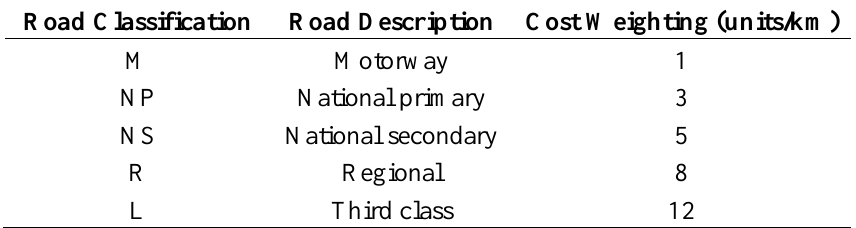
Table 2. Cost weights applied to road classes in the geometric